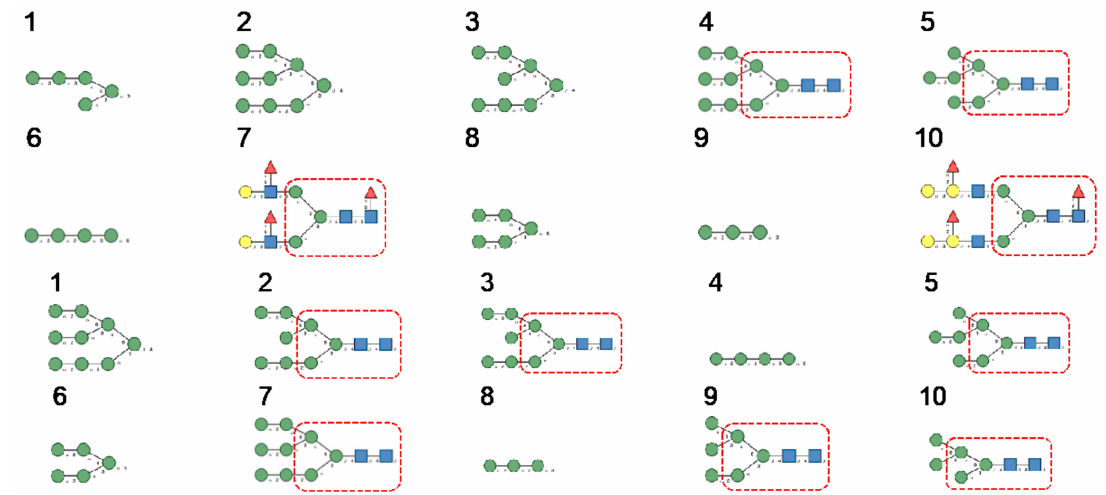
Figure 22. Glycans recognized by CVN-N in glycan array experiments, arranged from 1 to 10 in decreasing order of affinity.